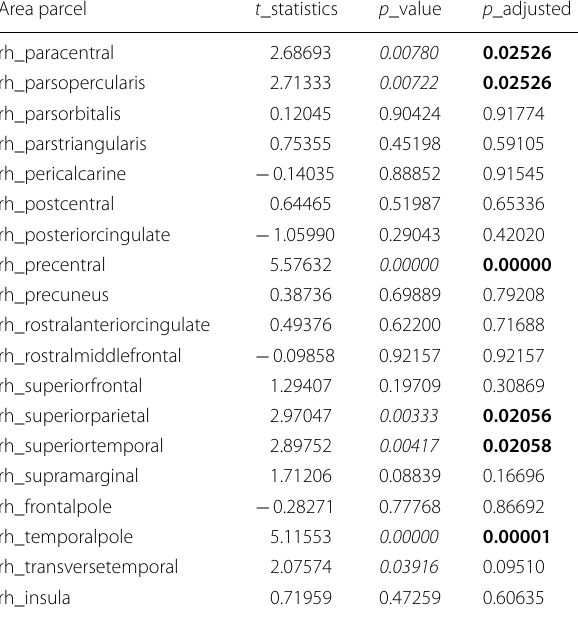
Table displays relations between MRI quality (CAT12 score) and cortical thickness for different brain parcels in Freesurfer’s DK atlas. The left side of the table shows regions in the left hemisphere, while the right side shows the right hemisphere. On each side, region is in the first column, and t-statistic (of CAT12 and cortical thickness) is in the second column. The third column is the uncorrected p -value, while the fourth column is this test statistic corrected for multiple comparisons (for all 68 parcels). Italics highlighting indicates regions that were p < .05 ( uncorrected ), while bold indicates regions that were p < .05 ( FDR corrected